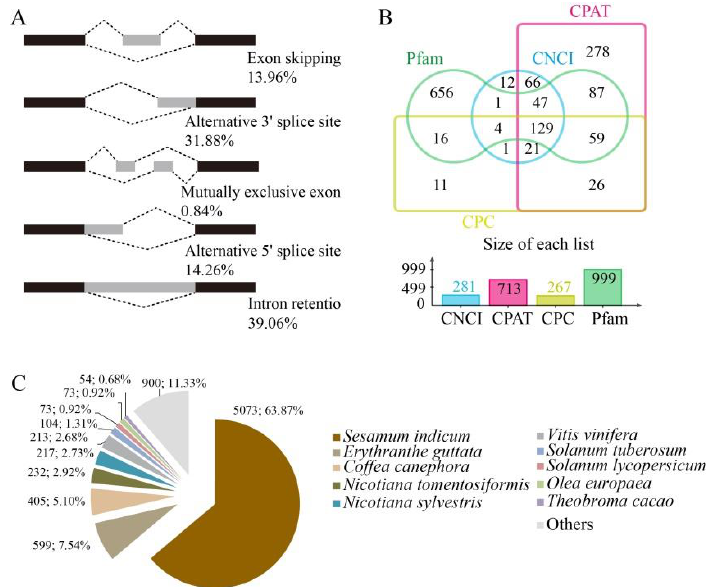
Figure 3. Transcriptomic based alternative splicing (AS), long non-coding RNA (LncRNA), and gene homologue analysis. ( A ) Five different major types of AS events were identified among transcripts. ( B ) Venn diagram showing LncRNAs identified by coding-non-coding index (CNCI), coding potential assessment tool (CPAT), coding potential calculator (CPC), and Pfam methods. ( C ) Distribution of homologous genes across species.